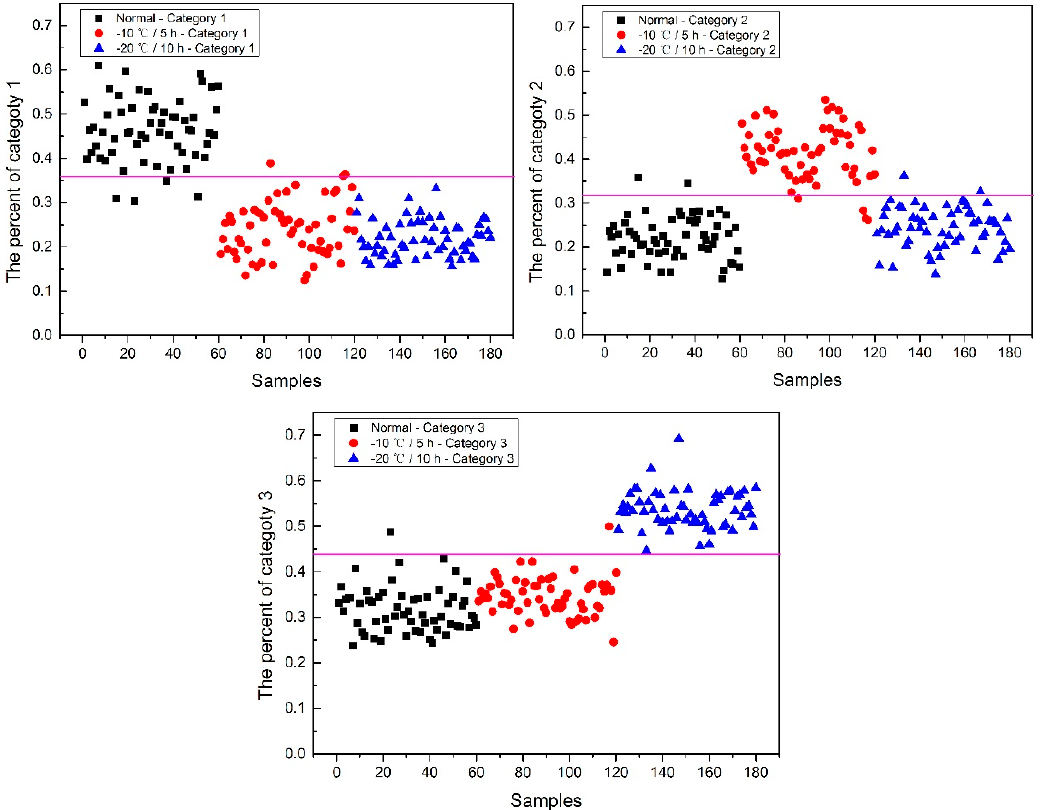
Figure 8. The percentage of each category of Haoyu21 with the SPA and PLS-DA model.